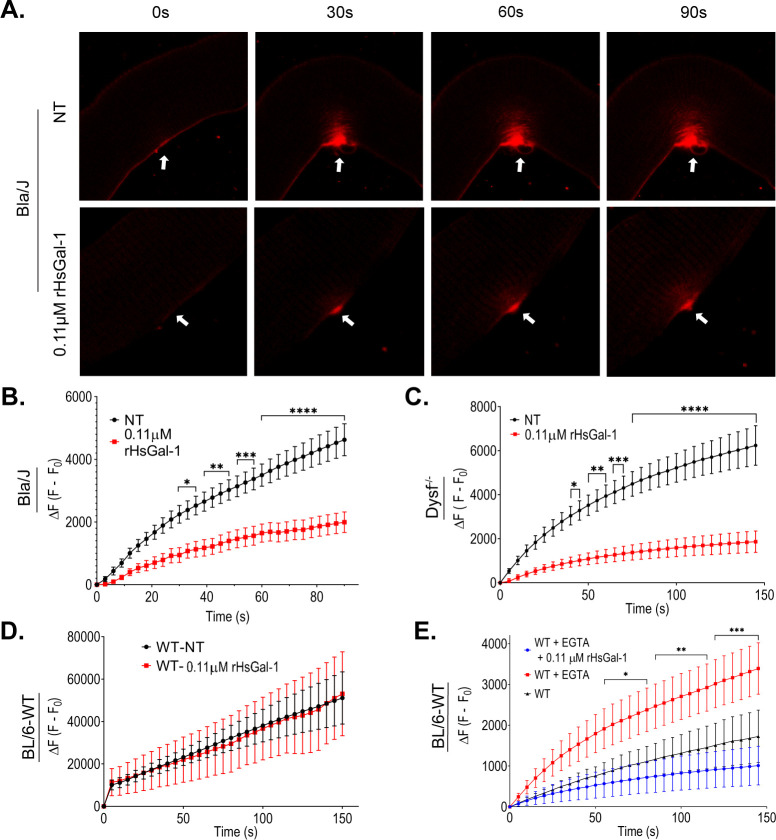
rHsGal-1 treatment positively effects sarcolemma and membrane repair in a Ca2+ depleted environment.A. Representative images at time points 0s, 30s, 60s, 90s of FM1-43 dye accumulation in Bla/J mouse fibers upon laser injury with a 405nm laser. White arrows indicate site of injury. B. Quantification of the total change of fluorescence in Bla/J myofibers. C. Quantification of the total change of fluorescence in Dysf-/- myofibers post injury. D. Quantification of the change in fluorescence in C57BL/6-WT myofibers after treatment with or without rHsGal-1. E. Quantification of the change in fluorescence in C57BL/6-WT myofibers after treatment with or without EGTA and rHsGal-1. p values were measured by Tukey’s multiple comparison test and indicated by *p< 0.05, **p< 0.01, and ***p< 0.001. Scale bars = 50 μm. Error bars represent SEM. n≥ 15 myofibers per condition.